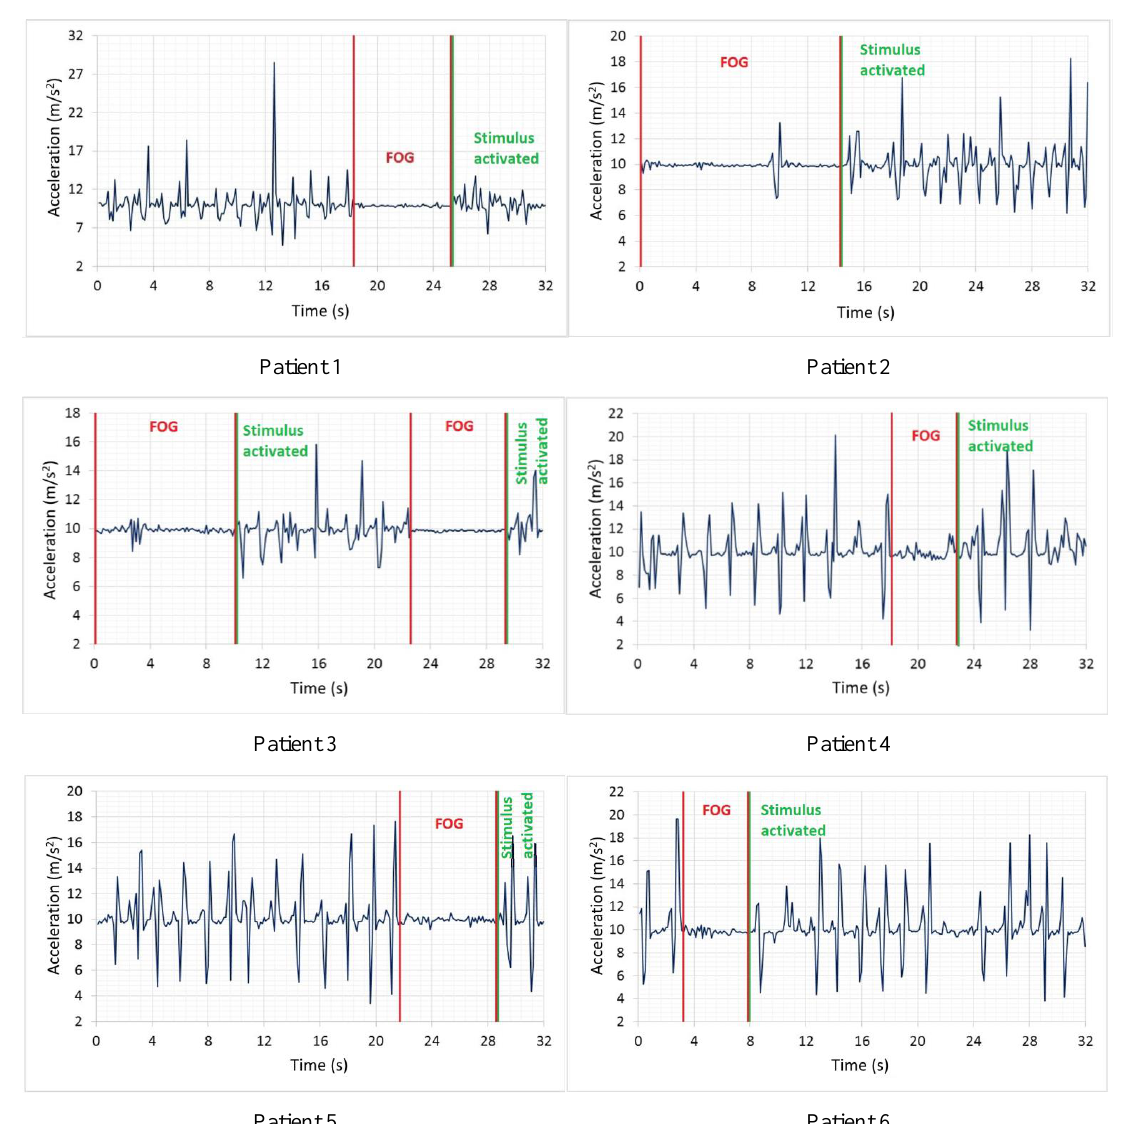
Figure 6. Signals of patients with FOG.